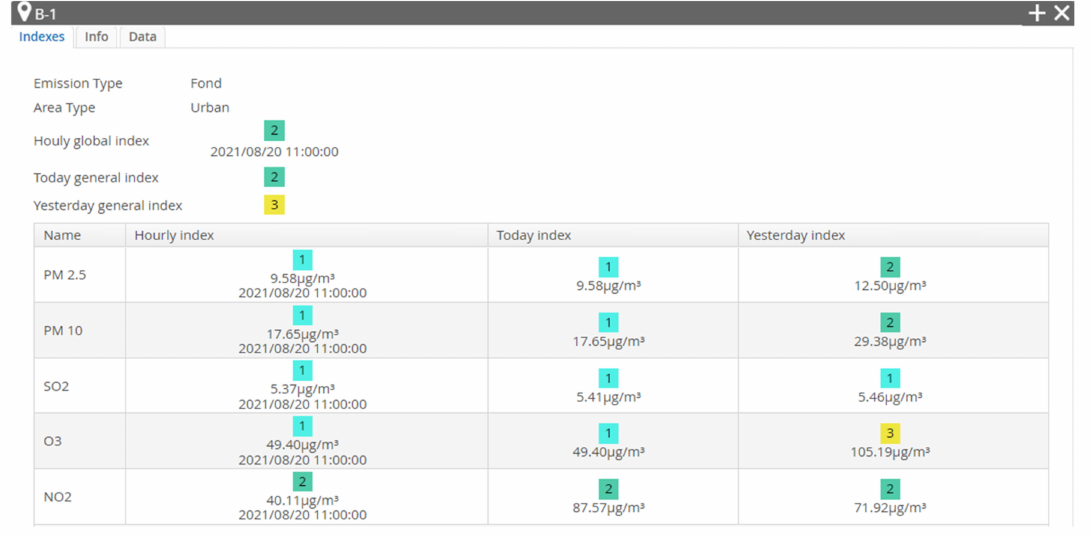
Figure 4. Indexes collected by station B-1